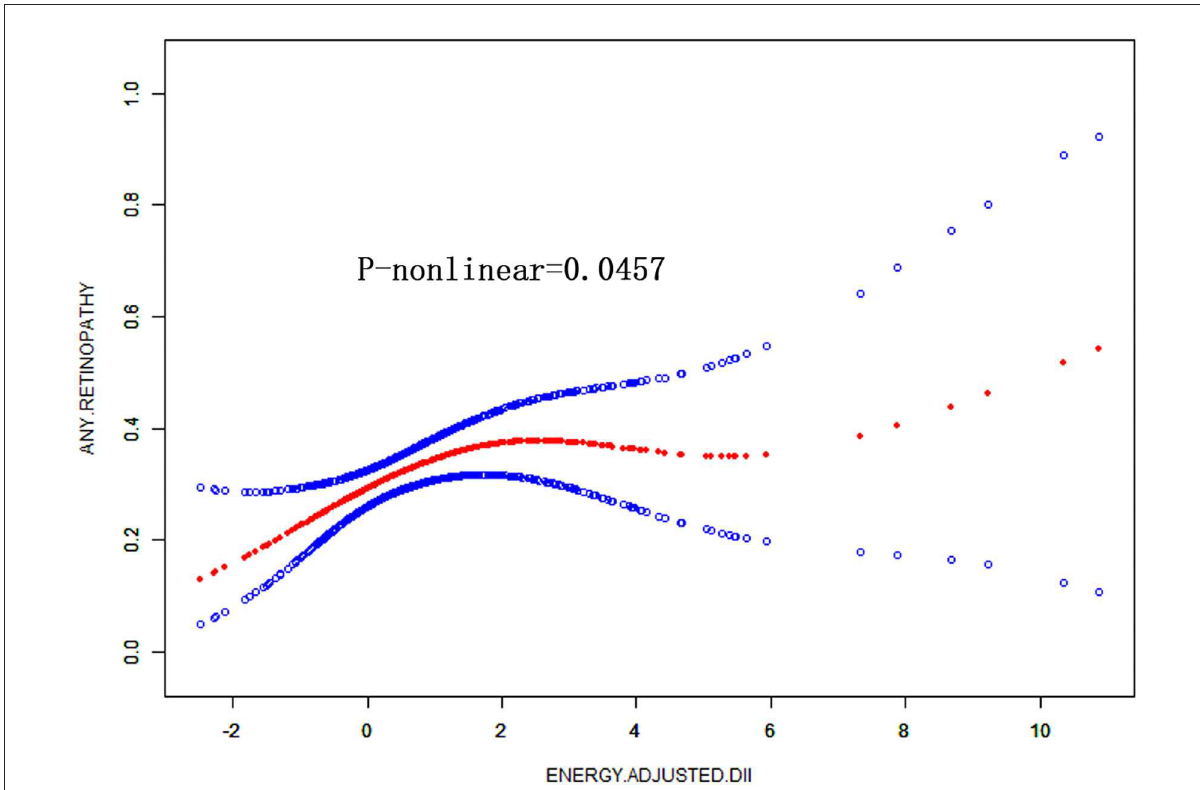
FIGURE2 Non-linear relationship between DII and the prevalence of retinopathy in diabetes by the generalized additive model after adjusted for gender, age, race ethnicity, educational level, marital status, family PIR, smoking status, and BMI.